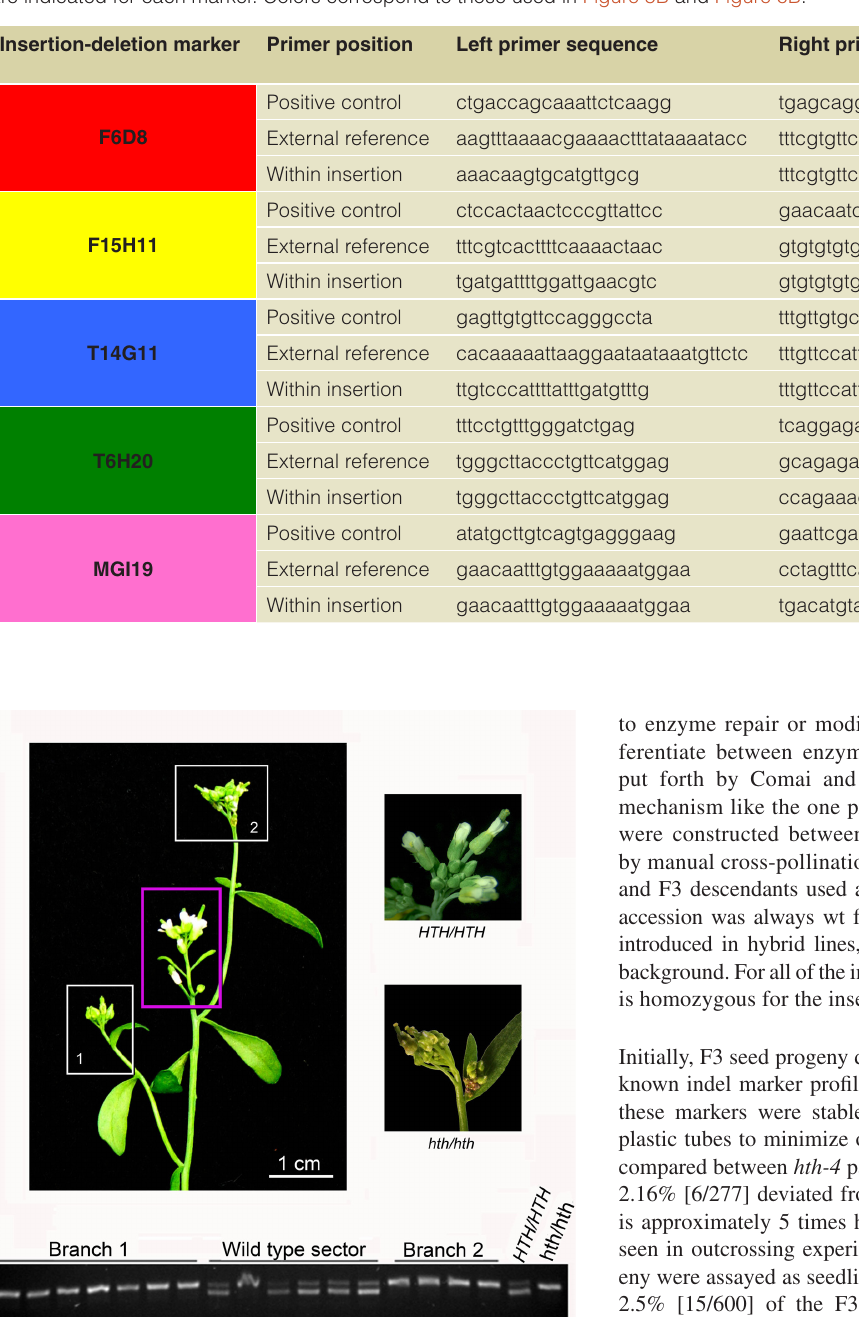
Table 2. List of primer sets used for qPCR analyses. Primer positions, left and right primer sequences and expected amplicon sizes are indicated for each marker. Colors correspond to those used in Figure 5B and Figure 6B.